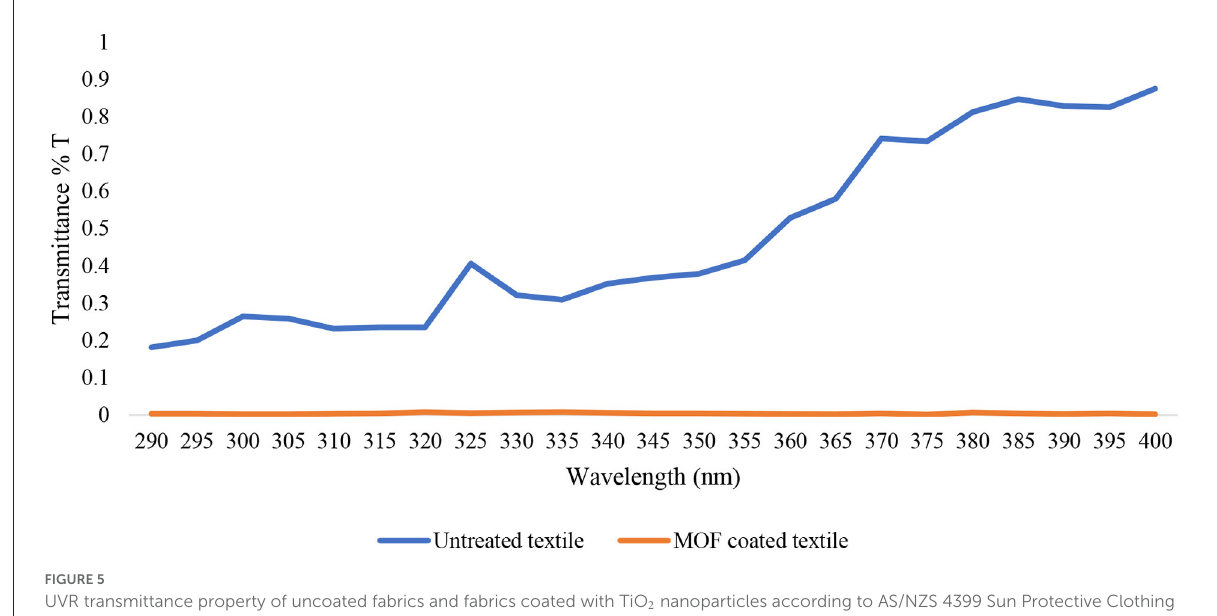
TABLE 1 Comparison of uncoated and coated textile with TiO 2 nanoparticle in terms of intrinsic properties of the textile. Textiles Intrinsic properties of the textile